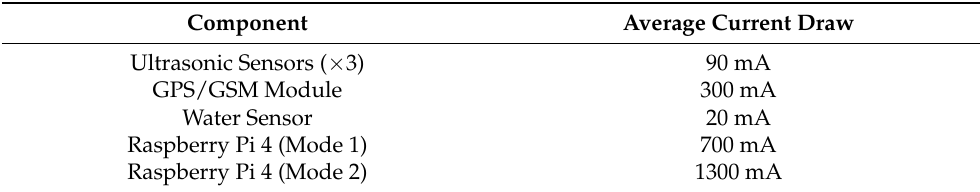
Table 5. Current drawn by different components.